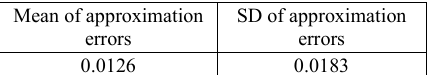
Table 4 Statistical analysis of torque characteristics in master–semi-master cooperative motion.